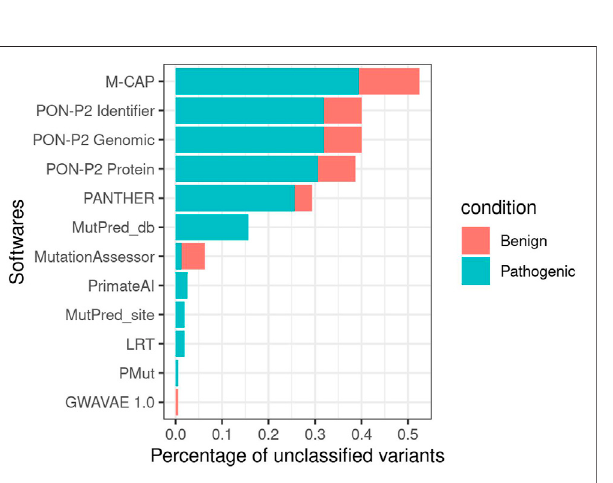
Frontiers in Molecular Biosciences |